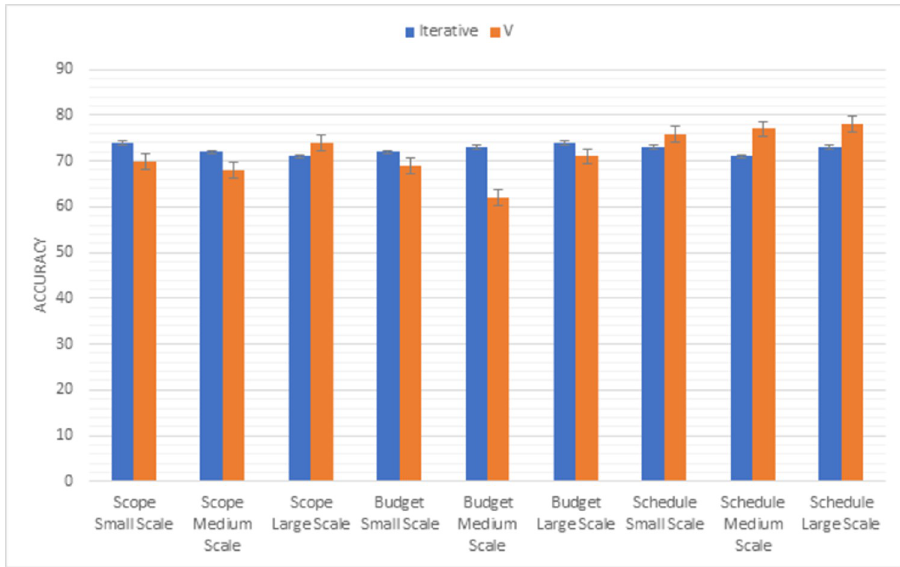
Fig 11. Graphical representation of iterative vs V (first triangle)